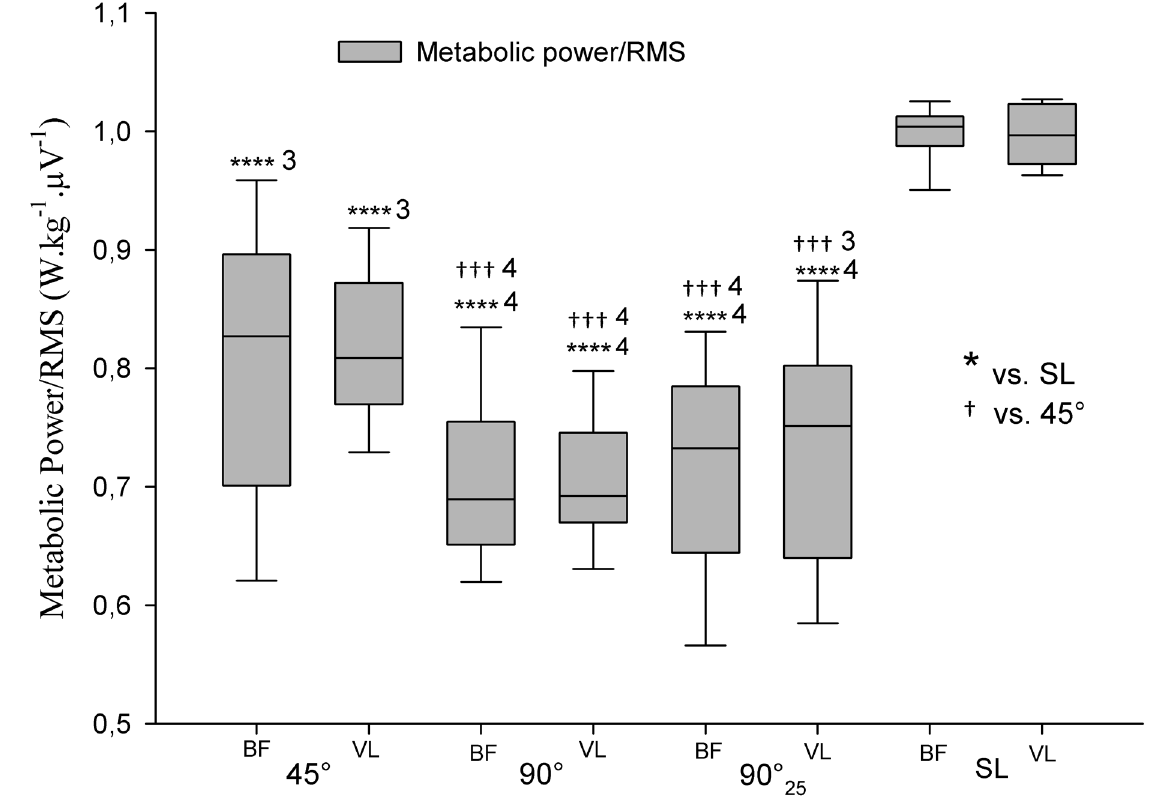
Fig 6. Metabolic power/electromyography amplitude (RMS) ratio of sprints with (45° or 90°) or without (i.e., straight-line (SL)) one change of direction (COD). 90° 25 : 25-m sprint with one 90°-COD; BF: biceps femoris; VL: vastus lateralis. The number of ‘ * ’ and ‘†’ refers to possible, likely, very likely and almost certain difference versus straight-line and 45°-COD sprints, respectively. The associated numbers represent the magnitude of the standardized difference, with 1 standing for small, 2 for moderate, 3 for large and 4 for very large